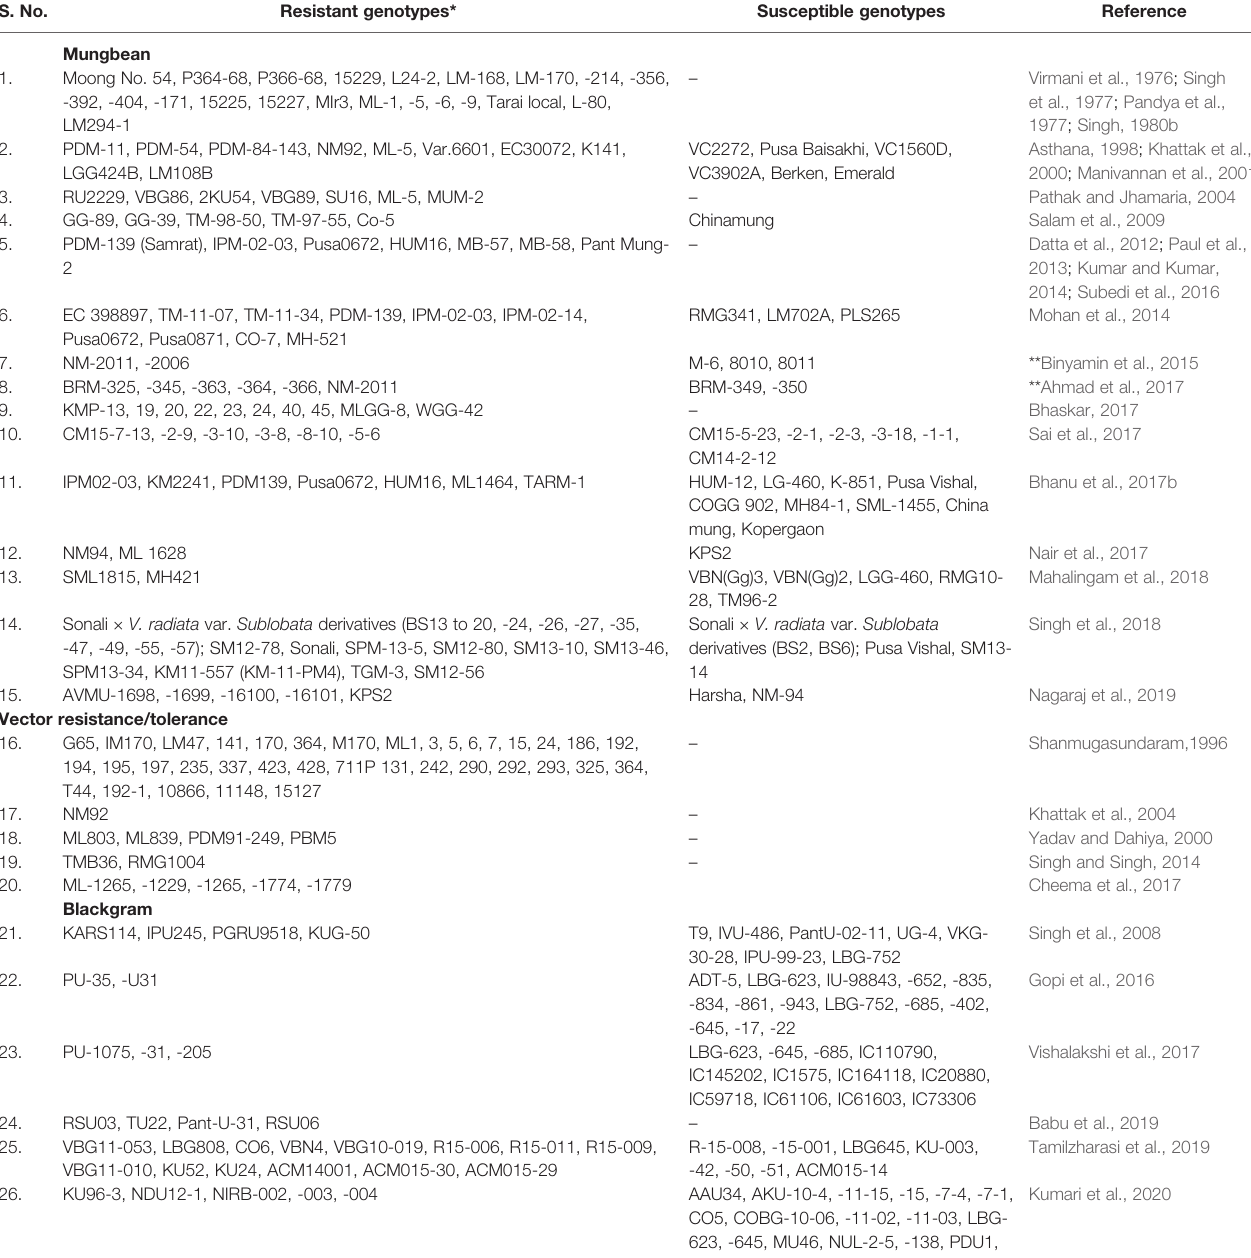
TABLE 2 | A timeline of mungbean and blackgram genotypes, reported as YMD resistant and susceptible by different researchers. S.